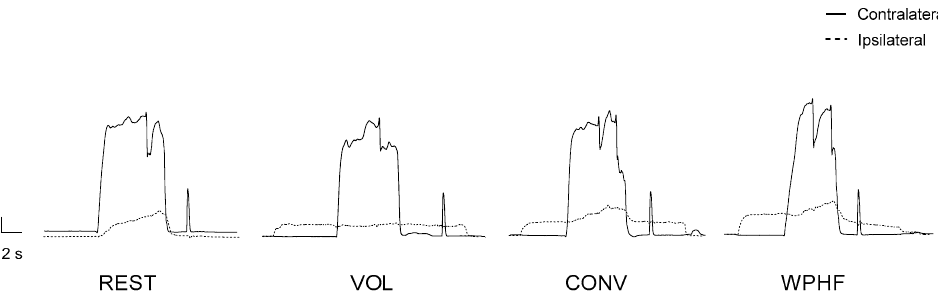
Figure 4. Plantar flexor torque recordings from one participant. The torque–time traces of the con-